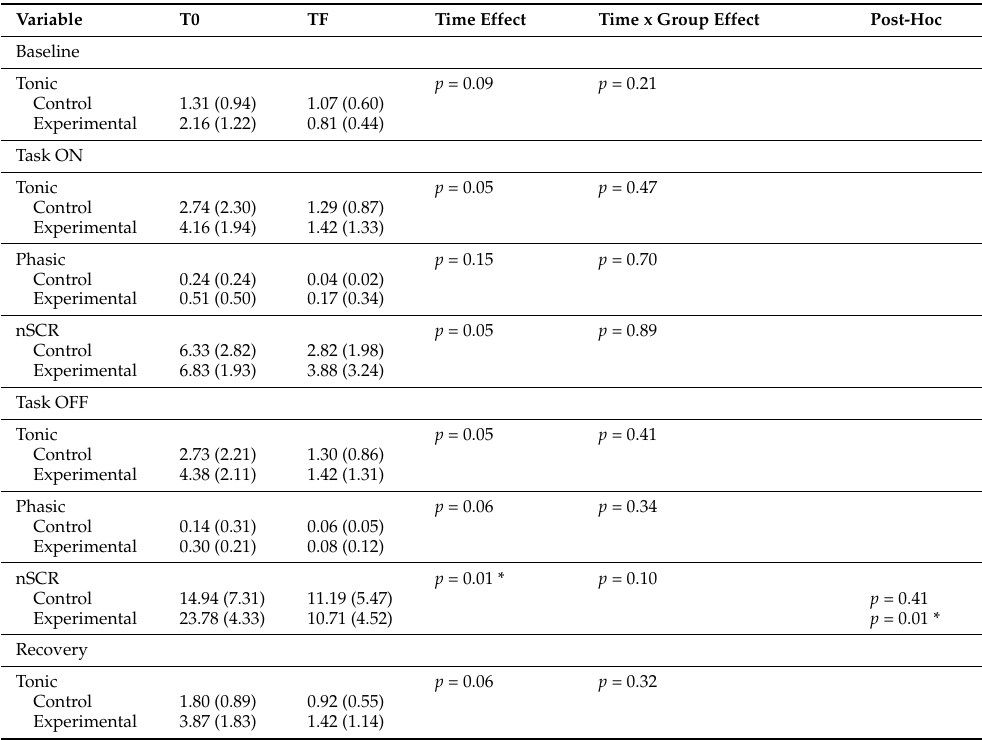
Table 4. Difference in skin conductance variables from T0 to TF in control and experimental groups. Variables are expressed as Mean (SD). * p <